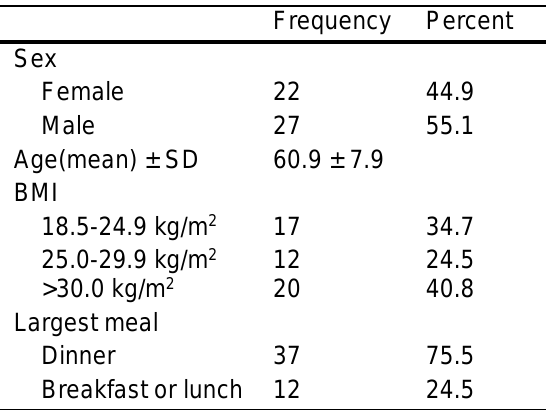
Table 1: Characteristics of the study population